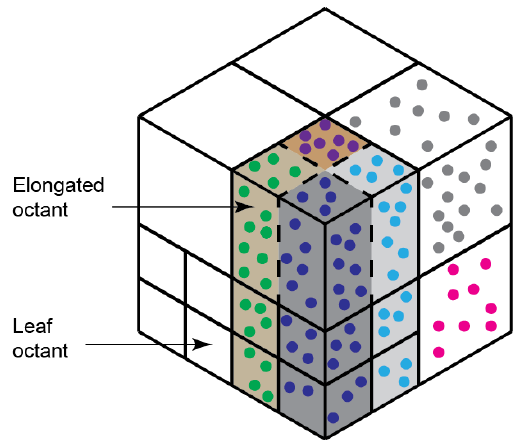
Figure 9. An illustration of an Octree with leaf octants elongated to a root node.